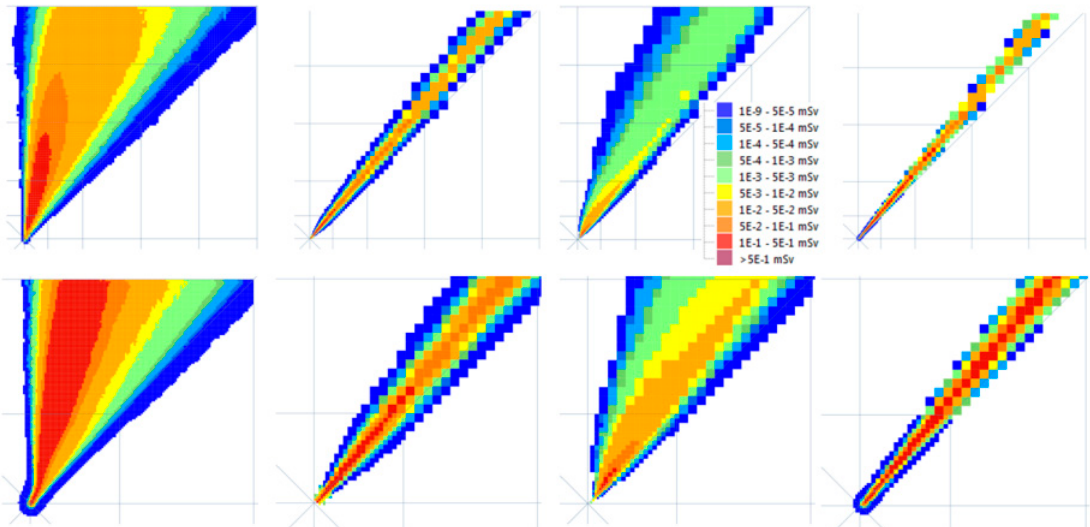
Figure 3. Which one to trust? Effective doses projected by four models used in Germany (ABR-KFÜ, ATSTEP, DIPCOT, and RIMPUFF) for an area of 100 × 100 km (top) and 25 × 25 km (bottom). Source: (the Federal Office for Radiation Protection (BfS), 2016).